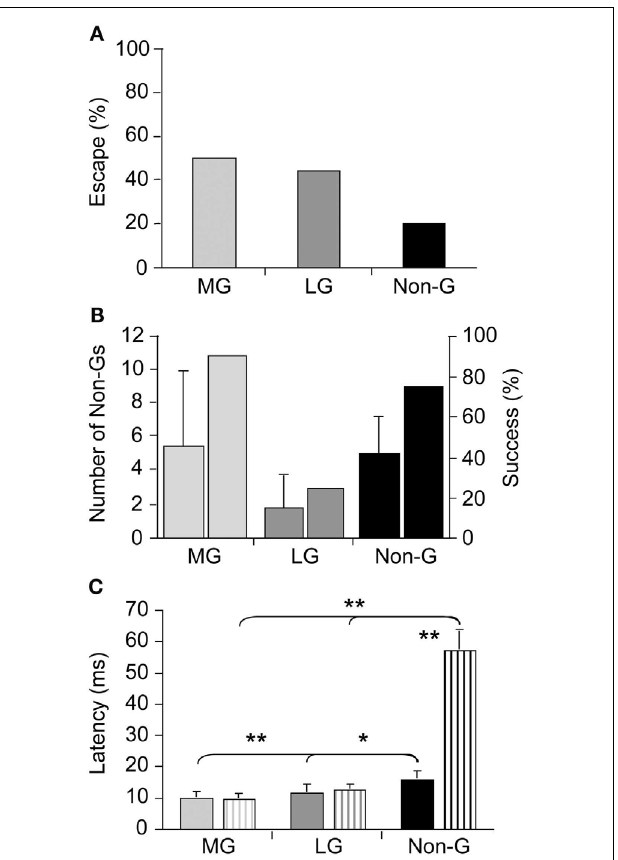
FIGURE 1 | Escape success and latencies measured in juvenile crayfish attacked by dragonfly nymphs. (A) Attacks evoking tail-flips mediated by the medial giant (MG) or lateral giant (LG) interneurons are equally effective to prevent capture whereas attacks eliciting non-giant (Non-G) tail-flips are much less effective. (B) Unsuccessful MG and Non-G, but not LG responses are frequently followed by a series of Non-G tail-flips (left bars), which substantially increase the overall rate of escape (right bars). (C) Escape latencies for crayfish attacked by predators (solid bars) or stimulated with a handheld probe (striped bars) are similar for giant mediated (MG and LG) tail-flips, but significantly shorter for predator evoked Non-G tail-flips. Modified from Herberholz et al.